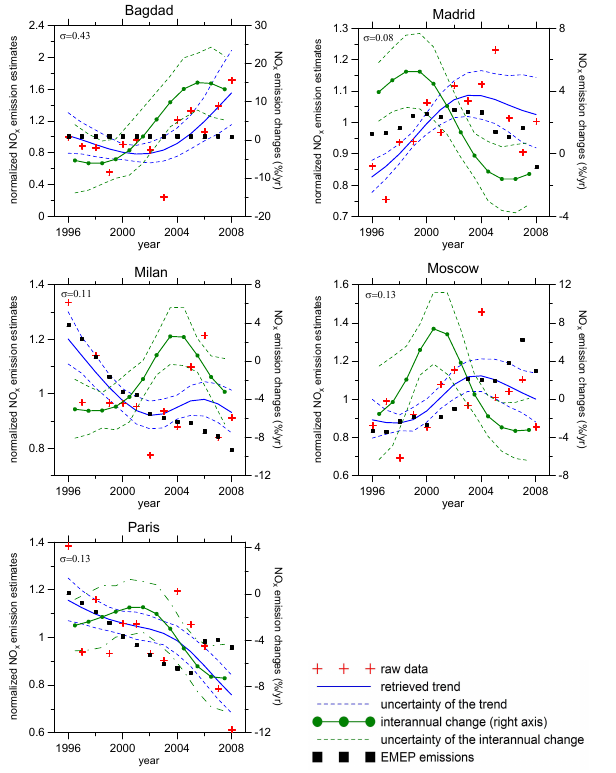
Fig. 7. Trends in NO x emission estimates retrieved from satel- lite measurements in comparison with corresponding NO x emission data derived from the EMEP inventory. The results are obtained with two neurons in the network ( N =2). The uncertainties are eval- uated in terms of the 68.3 percentile using estimates of the noise level ( σ , see Eq. (10)) shown in the plots.